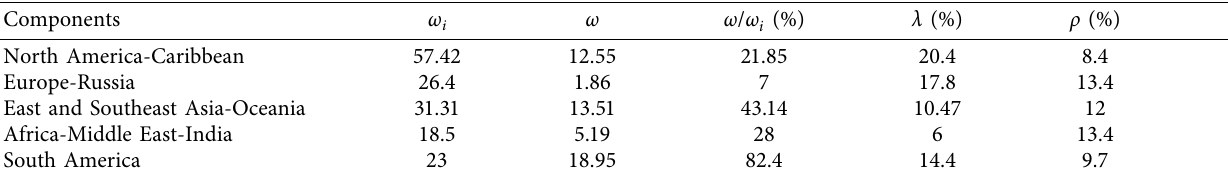
Table 7: Evolution of the weighted efciency and the LCC of the large local components after their isolation due to attacks based on weighted PageRank. We also report the order of isolation of the components. ω i is the weighted efciency before the attack based on PageRank. ω is the weighted efciency after the separation. λ is the largest connected component size after the split. ρ is the fraction of top PageRank nodes removed from the world air transportation network to isolate the component. c is the order in which the components are isolated. Isolating the components reduces their efciency signifcantly.